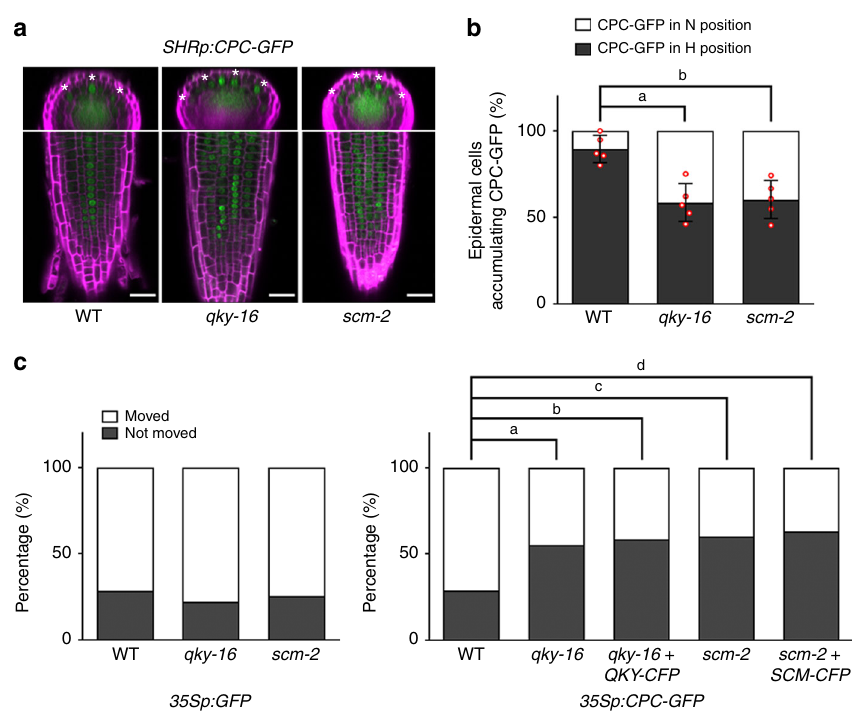
Fig. 3 QKY and SCM control CPC movement between epidermal cells. a CPC-GFP accumulation in the root epidermis of various plants harboring the SHRp: CPC-GFP translational fusion. The H-position epidermal cells are marked with an asterisk. Bar = 25 μ m. b Quantitative analysis of the stele-produced CPC- GFP movement to the epidermis of ( a ). Values represent means ± SD of fi ve individual 4-day-old seedlings. In each seedling, at least 20 cells accumulating CPC-GFP were examined and their position was scored. Statistical signi fi cance was determined by one-way ANOVA with Bonferroni ’ s post hoc test, and the P values for a and b are 0.000756586988099 and 0.001224674739152, respectively. c Quantitative analysis of the CPC-GFP movement. GFP or CPC- GFP was transiently expressed in rosette leaves of indicated mutants using the Biolistic PDS-1000/He system and the leaves were incubated for their expression for 4 h. Quantitative analysis was performed using only sink cells in rosette leaves. Values indicate the percentage of cells showing GFP movement to the neighboring cells (white) and cells not showing GFP movement (black). At least 76 cells were counted for each experiment. Actual number of cells analyzed in each experiment can be found in Supplementary Fig. 2. Statistical signi fi cance of differences in the frequency was tested by chi- square test, and the P values for a, b, c, and d are 0.0000160, 0.0000490, 0.0000004, and 0.0000032,